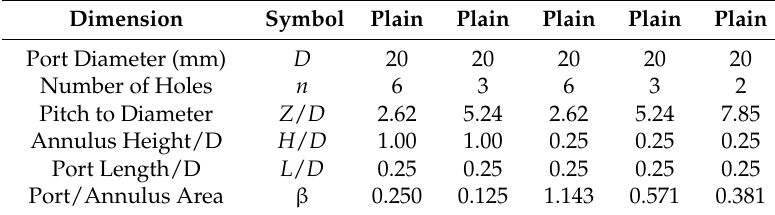
Figure 5. Parametric stepped port definition. Table 2. Plain port test configurations, waterflow rig with crossflow.